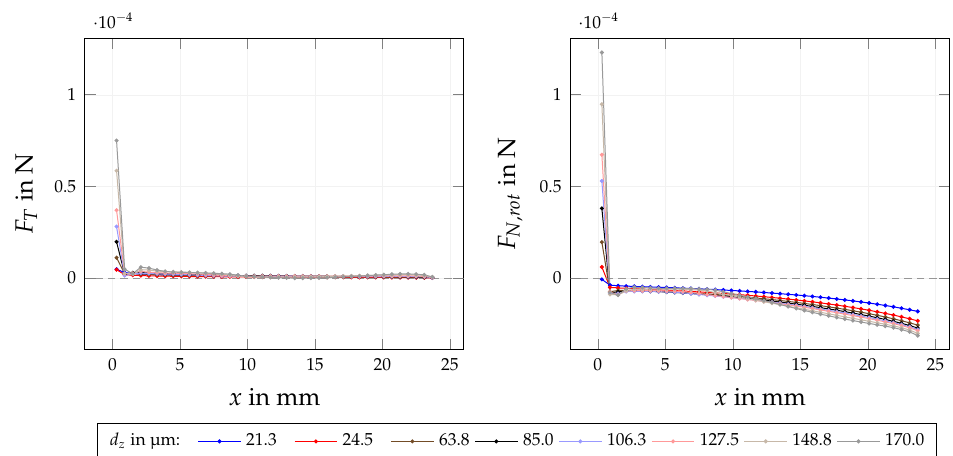
Figure 24. Distribution of tangential forces F t and rotation-induced normal forces F n , rot in central PM fragment row for different uniform layer heights d z .